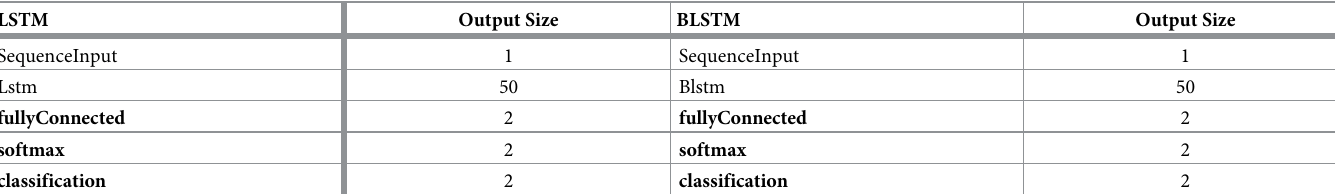
Table 4. LSTM and BLSTM architecture implemented in Matlab without transfer learning technique.